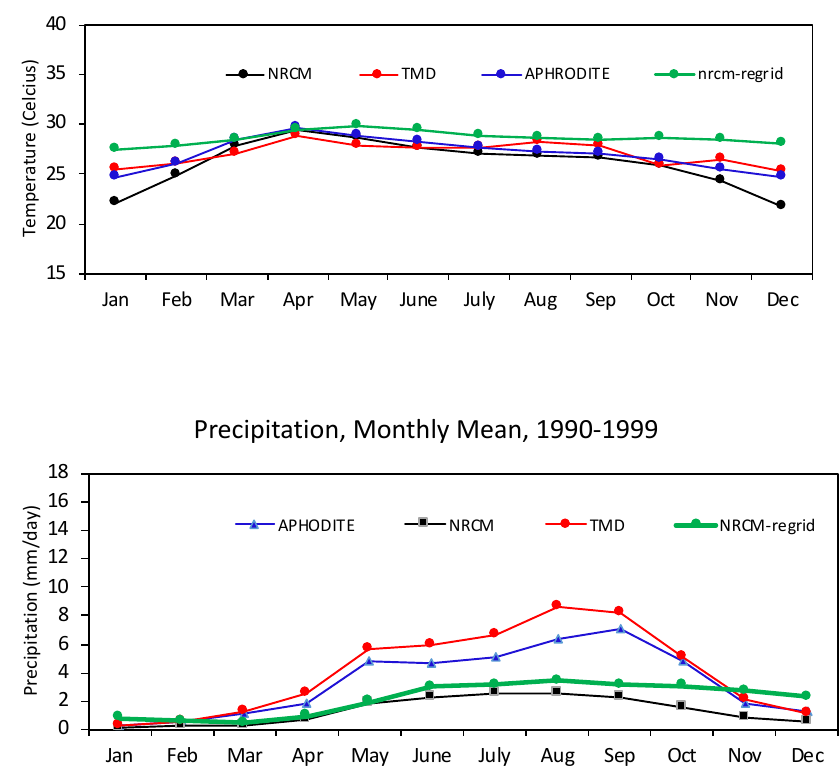
Figure 2. Monthly mean temperature (°C) and precipitation (mm/day) averaged over 1990–1999 based on 44 station locations from the Thai Meteorological Department (TMD), Asian Precipitation Highly Resolved Observational Data Integration Towards Evaluation of Water Resources (APHRODITE), Modern-Era Retrospective Analysis for Research and Applications (MERRA), Global Precipitation Climatology Project (GPCP) (Plus) and the Nested Regional Climate (NRCM) model. Table 3. Statistical analysis of the model and ground-based observations from the TMD. IOA: index of agreement. Statistical Analysis